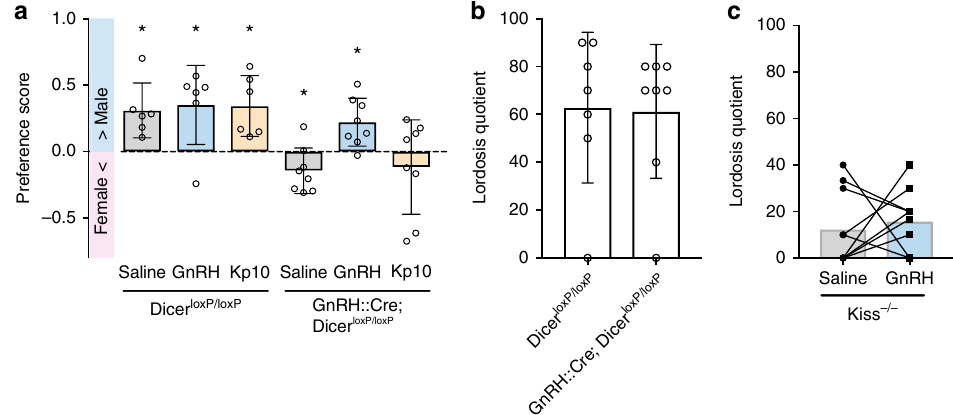
Fig. 4 Mate preference, but not lordosis, behavior depends on GnRH signaling. a Genetic disruption of Dicer in GnRH neurons abolishing GnRH expression in the GnRH::Cre; Dicer loxP/loxP mouse model induced a female- instead of a male-directed preference, whereas control littermates showed a preference for the male (saline condition). A single peripheral GnRH injection at a dose of 0.025 mg kg − 1 induced a male-directed preference in GnRH::Cre; Dicer loxP/loxP female mice, whereas a peripheral injection with kisspeptin (Kp-10) was not successful. * P ≤ 0.05; one-sample t test (H0: mean equals 0); n = 6 ( DicerloxP/loxP ) or 8 ( GnRH::Cre;DicerloxP/loxP ). b Strikingly, such disruption of GnRH expression in GnRH::Cre; Dicer loxP/loxP mouse model did not affect lordosis behavior. Mann – Whitney U test; P = 0.79; n = 7/8. c A single injection with GnRH failed to stimulate lordosis behavior in Kiss − / − mice. Paired t test; P = 0.65; n = 10. Bars represent the mean ± SEM. For all experimental details, see Supplementary Table